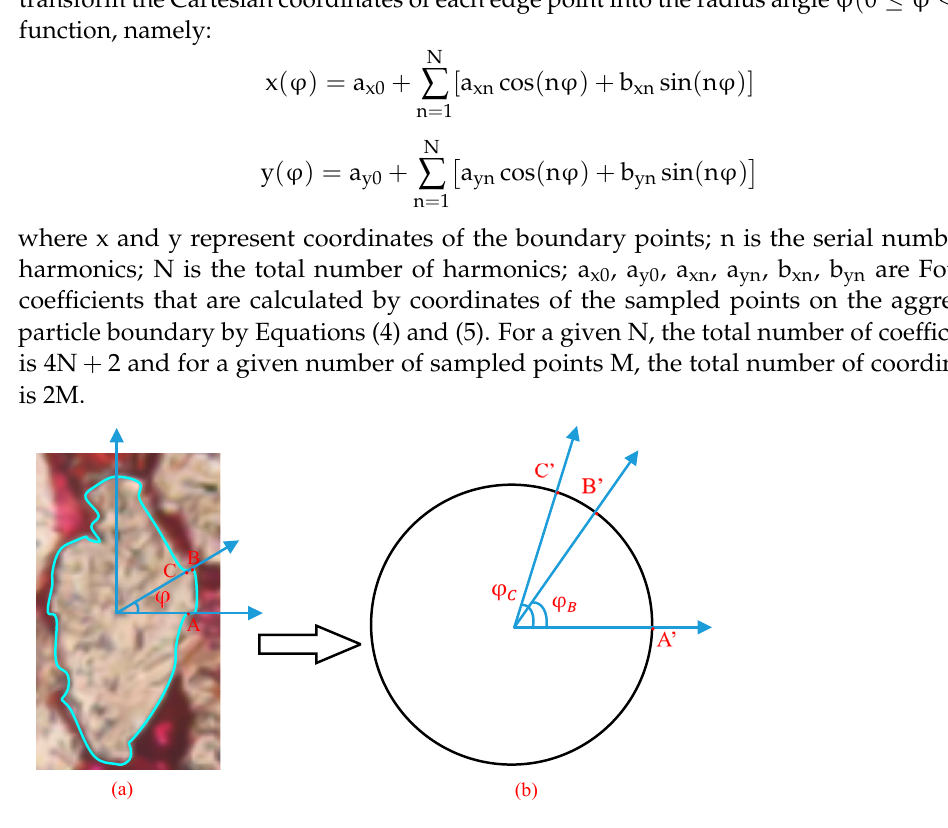
Figure 5. Circular parameterization process: ( a ) represents the original position of each component edge point, ( b ) represents the position of each edge point after cyclic parameterization.